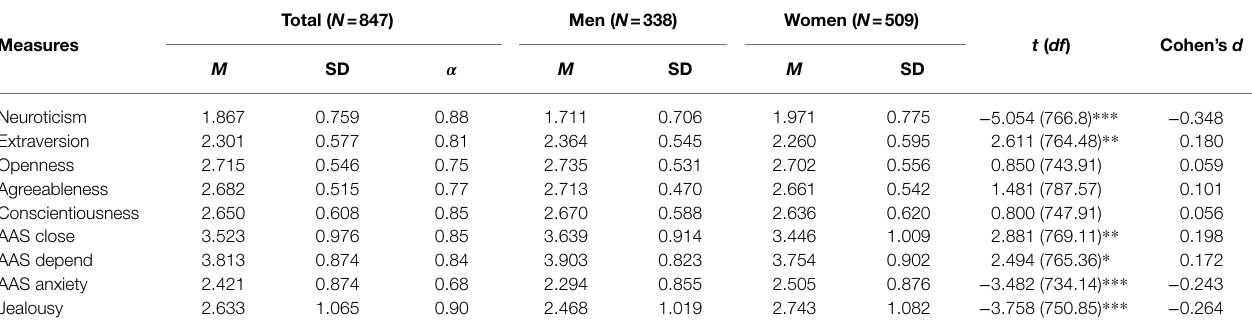
TABLE 1 | Mean ( M ) and standard deviation (SD), Cronbach’s α , and Welch’s t -tests evaluating gender differences for the measures of Big Five personality traits, the adult attachment dimensions close , depend, and anxiety, and romantic jealousy. Total ( N = 847) Measures